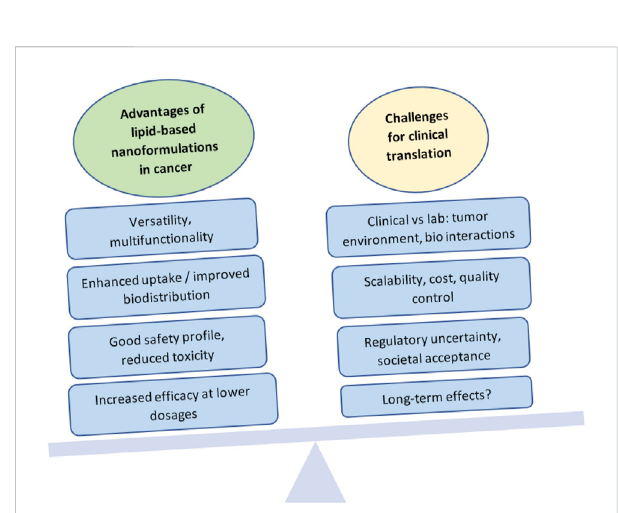
FIGURE 3 Advantages and challenges in the clinical translation of lipid- based nanoformulations for cancer management. Created with BioRender.com.